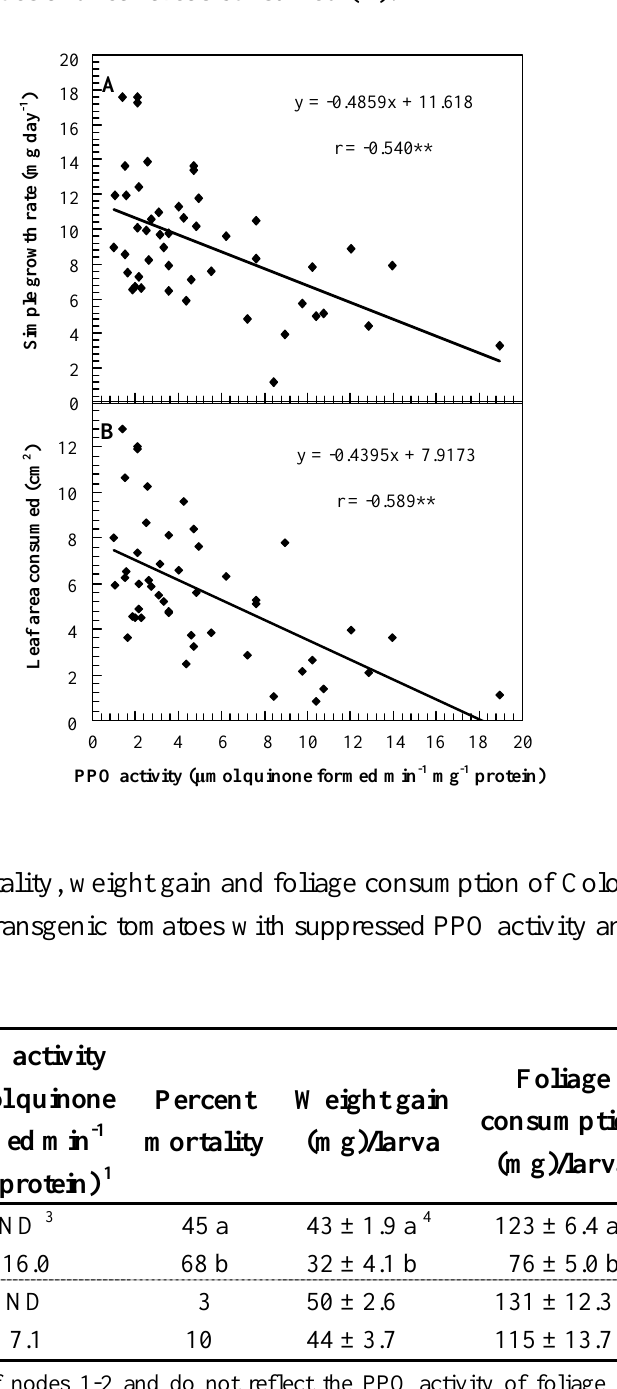
Figure 3. Correlation between PPO activities and simple growth rates of cotton bollworms ( Helicoverpa armigera ) feeding on leaflets at node 4 of transgenic plants with suppressed and overexpressed PPO activity segregating for PPO activity levels (A), and between PPO activities and leaf areas consumed (B).